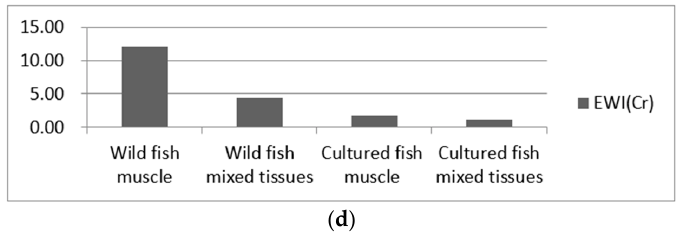
Figure 3. Calculation results of health risks of wild and cultured fish ( a ) through fish consumption based on target hazard quotients ( b ), carcinogenic risk ( c ) and estimated weekly intake ( d ). In order to explore the method for minimizing health risks through fish consumption, this study calculated the health risk associated with mixed fish (wild:cultured =1:1) consumption to balance the risks calculated by three different models. The total fish ingestion rate remained 54.33 g/day. The calculation results of consuming cultured fish mixed with wild fish compared with consuming cultured fish or wild fish separately are shown in Figure 4a–c.